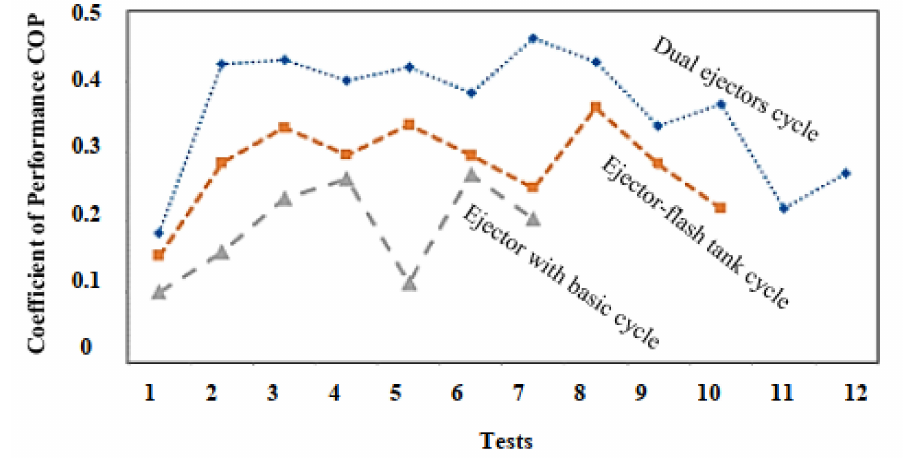
Figure 10. The thermal COP of different cycle configurations in several testing days